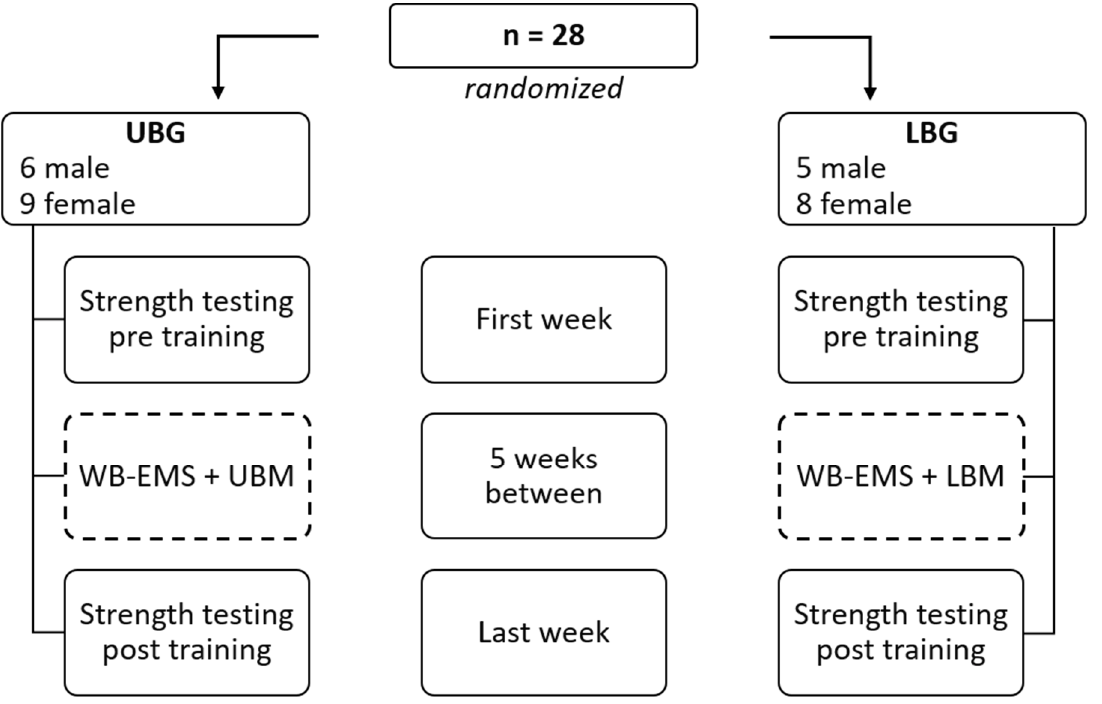
Figure 1. Overview of the study design and procedure. UBG: upper body group; LBG: lower body group; WB-EMS: whole-body electromyostimulation (dashed frame); UBM: upper body exercise movements; LBM: lower body exercise movements.